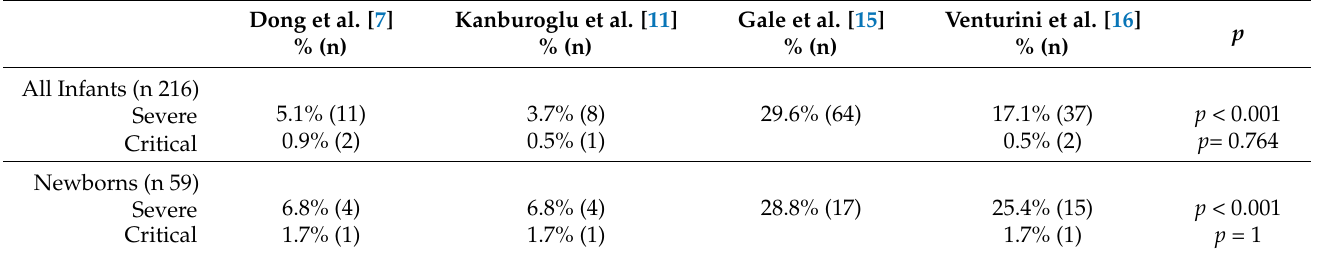
Table 5. Severity classifications according to different definitions.